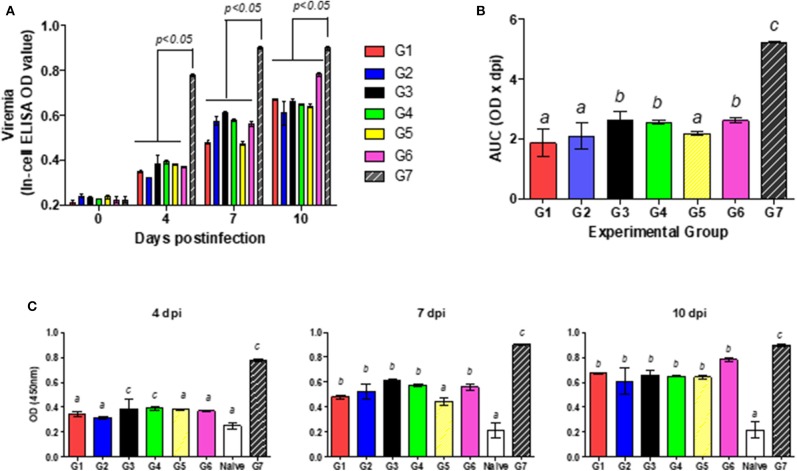
Effect of combined treatment in viremia. (A) Viral replication was measured as the mean OD450 levels ± the SD reflecting the NS3 titer, for each of the experimental groups G1–G7. (B) The mean value ± the SD for the area under the curve (AUC) resulting from the bar heights in (A) from days 1 through 10 is plotted for each of the experimental groups G1–G7. (C) Viral replication was measured as in (A) for each individual animal in the groups G1–G7 plus Group G8 (the naïve mice) at Day 4 (left figure), Day 7 (middle figure), and Day 10 (right figure) post-infection. In (B,C), different letters above the bars mark significant differences between groups (p < 0.05).